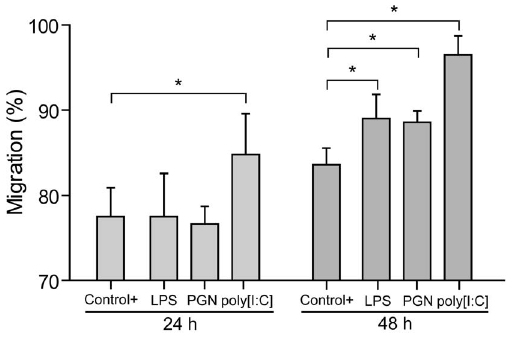
Figure 3. Trophoblast cells restrain maternal monocytes migration depending on the pathological stimuli. Migration assays were performed in transwell system. Condition media from Swan-71 cells cultured in the absence or presence of LPS (10 m g/ml), PGN (10 m g/ml), or poly [I:C] (10 m g/ml) was used in the lower compartment as attractant and 8 m m-pore inserts were added containing the isolated monocytes (upper compartment). After 24 and 48 hours, cells were recovered from the lower and upper compartments and the frequency of CD14 + cells were quantified by FACS analysis. As a positive control, we used 20% human AB serum. Results are expressed as percentage of migration (mean 6 SEM) from 4 migration assays using different fertile women (*p , 0.05, Friedman test followed by Dunn’s post-test).